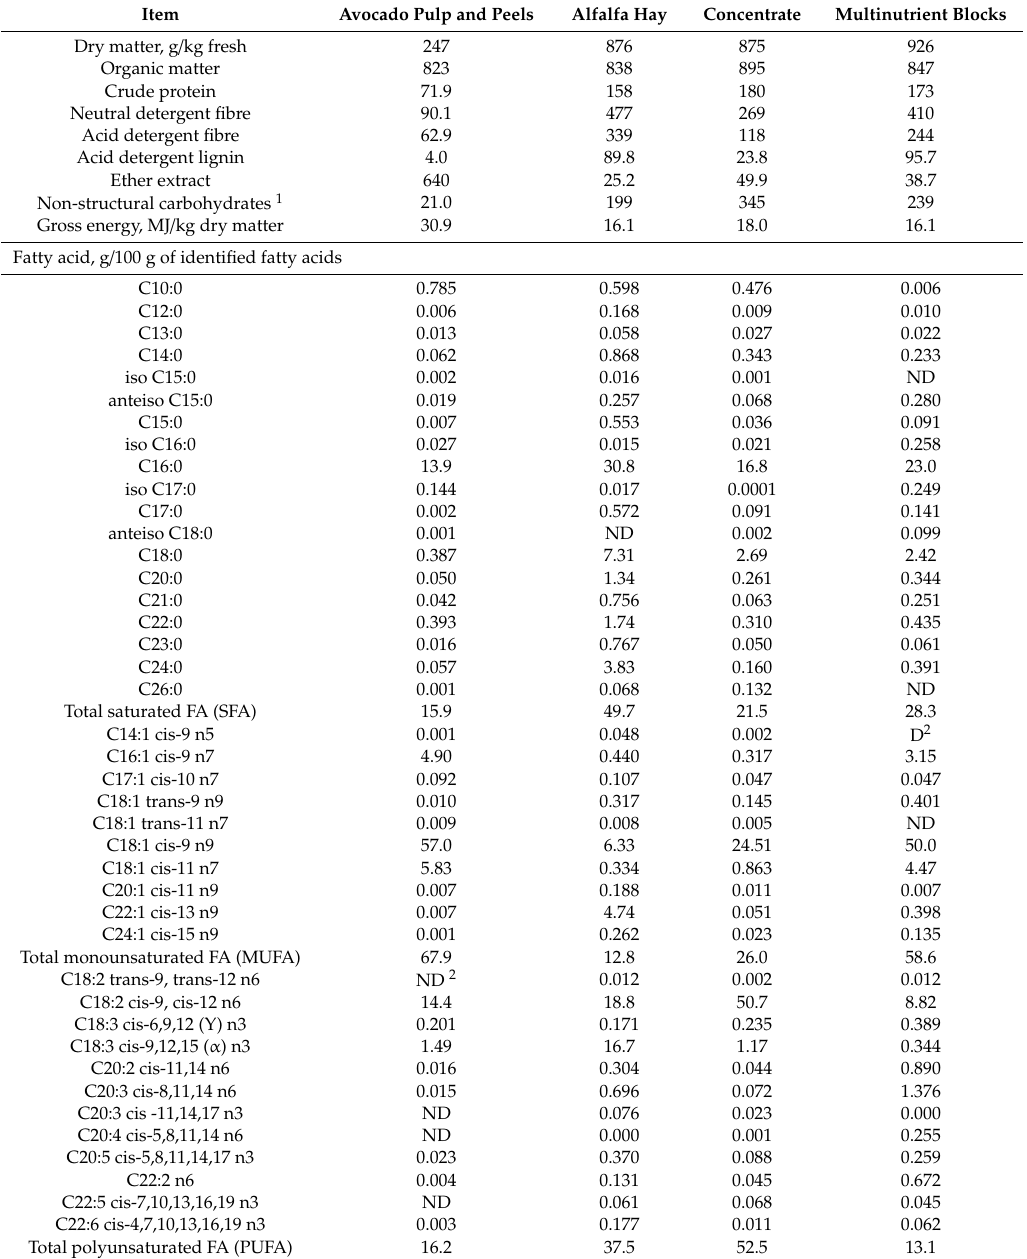
Table 2. Chemical composition (g / kg dry matter unless otherwise indicated) and fatty acid (FA) profile of the ingredients of the experimental